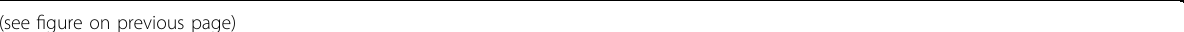
Fig. 6 Noninvasive bioluminescence imaging of chemotherapy-induced autophagy fl ux in live animals. A Representative bioluminescence images of A2780Dual ER tumor xenograft-bearing mouse expressing mtFL-p62 autophagy sensor treated with vehicle (untreated), CisPac, Trametinib, CQ, CisPac + Trametinib, and CisPac + CQ and monitored over 14 days. B Graphical representation of kinetics of quanti fi ed bioluminescence signal from mice ( n = 8) showed Trametinib treatment alone enhanced (1.60-fold) bioluminescence on day 4 [(2.14 × 10 6 ± 0.44 × 10 6 vs. 1.33 × 10 6 ± 0.28 × 10 6 p/s/cm 2 /sr, (day 0)], which remained stationary till day 14 (2.29 × 10 6 ± 0.85 × 10 6 p/s/cm 2 /sr). A similar kinetics was observed with CQ treatment alone with a 1.66-fold increased luminescence on day 4 [(2.56 × 10 6 ± 0.56 × 10 6 p/s/cm 2 /sr vs. 1.54 × 10 6 ± 0.53 × 10 6 p/s/cm 2 /sr (day 0)] that remained stationary till day 14 (2.62 × 10 6 ± 0.58 × 10 6 p/s/cm 2 /sr). In contrary, CisPac treatment resulted in slow but continued reduction in bioluminescence [(3.17 × 10 6 ± 0.65 × 10 6 (day 0) to 2 × 10 6 ± 0.31 × 10 6 (day 2) to 1.82 × 10 6 ± 0.28 × 10 6 (day 4) to 1.08 × 10 6 ± 0.18 × 10 6 (day 14) p/ s/cm 2 /sr), ~0.34-fold]. Application of Trametinib along with CisPac tripled luminescence signal by day 2 [(2.01 × 10 6 ± 0.37 × 10 6 (day 0) to 6.29 × 10 6 ± 1.36 × 10 6 (day 2)] then remained steady at day 4 (6.62 × 10 6 ± 1.69 × 10 6 p/s/cm 2 /sr) followed by a drop on day 6 (2.92 × 10 6 ± 0.62 × 10 5 p/s/cm 2 /